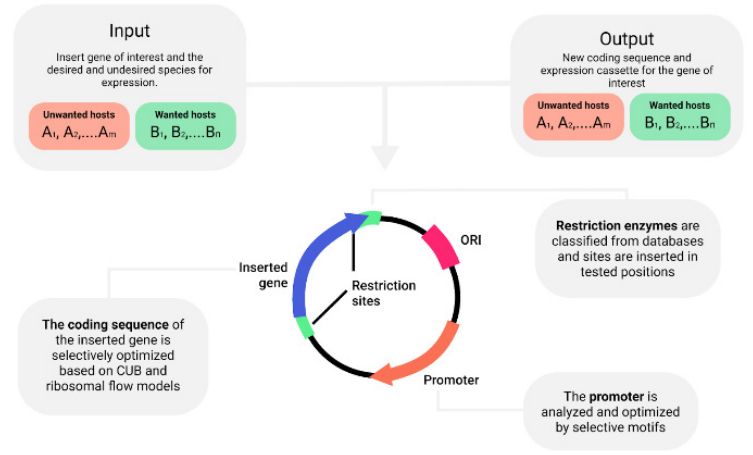
Figure 2. A microbiome specific plasmid and it’s designed elements.